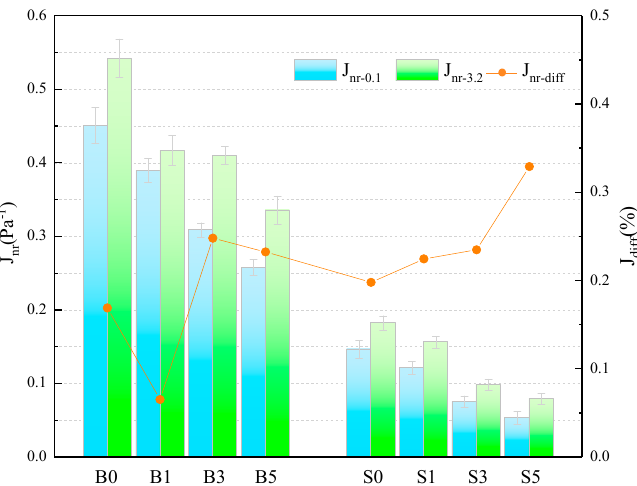
Figure 4. Calculation of the relevant parameters for the J nr.